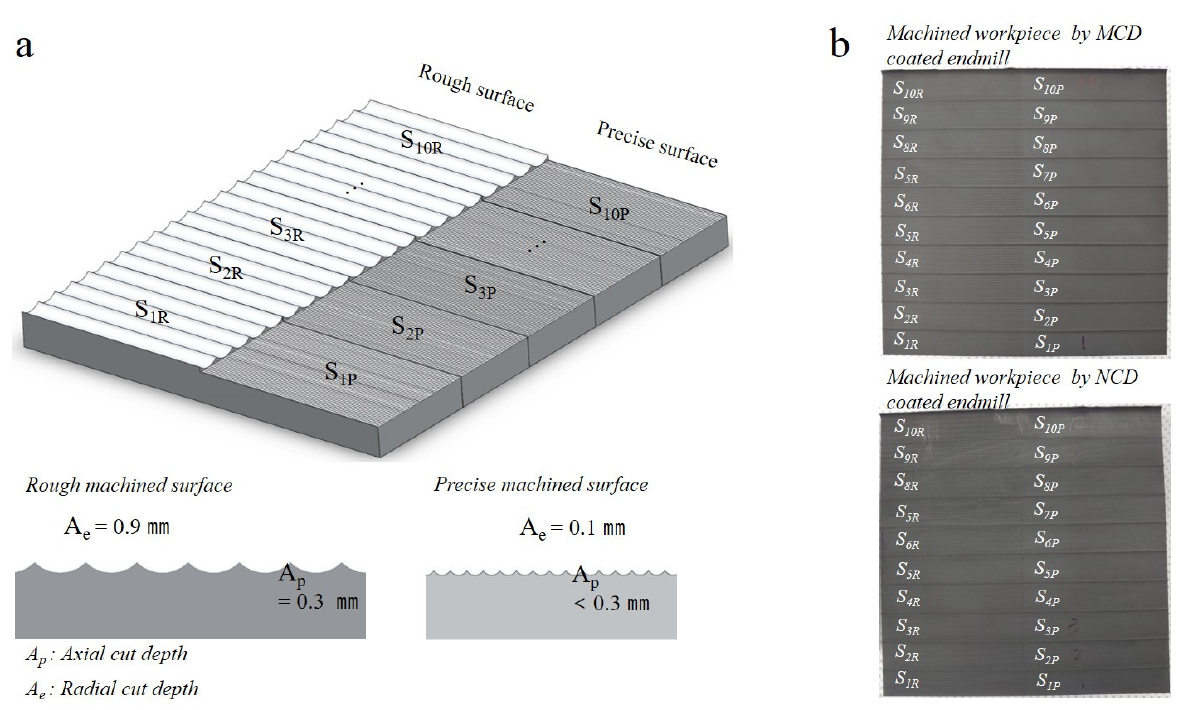
Figure 8. ( a ) Diagram of machined surface morphology after milling. ( b ) Optical microscope images of machined surfaces after rough and precision milling processes using MCD and NCD-coated tools.